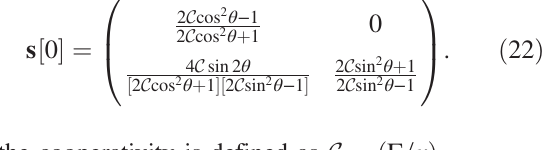
FIG. 3. s -matrix elements of the directional, phase-preserving amplifier, as a function of scaled frequency; the cooperativity C ≡ Γ = κ ¼ 0 . 95 , where Γ is the dissipative interaction strength and κ is the damping rate of cavities 1 and 2. (a) Auxiliary mode damping κ 0 ¼ κ , indicating a strong deviation from the Marko- vian limit; while perfect isolation exists at ω ¼ 0 , it is rapidly lost for nonzero frequencies. (b) Auxiliary mode damping κ 0 ¼ 100 κ , closer to the Markovian limit. The directionality is much better at finite frequencies, while the gain is